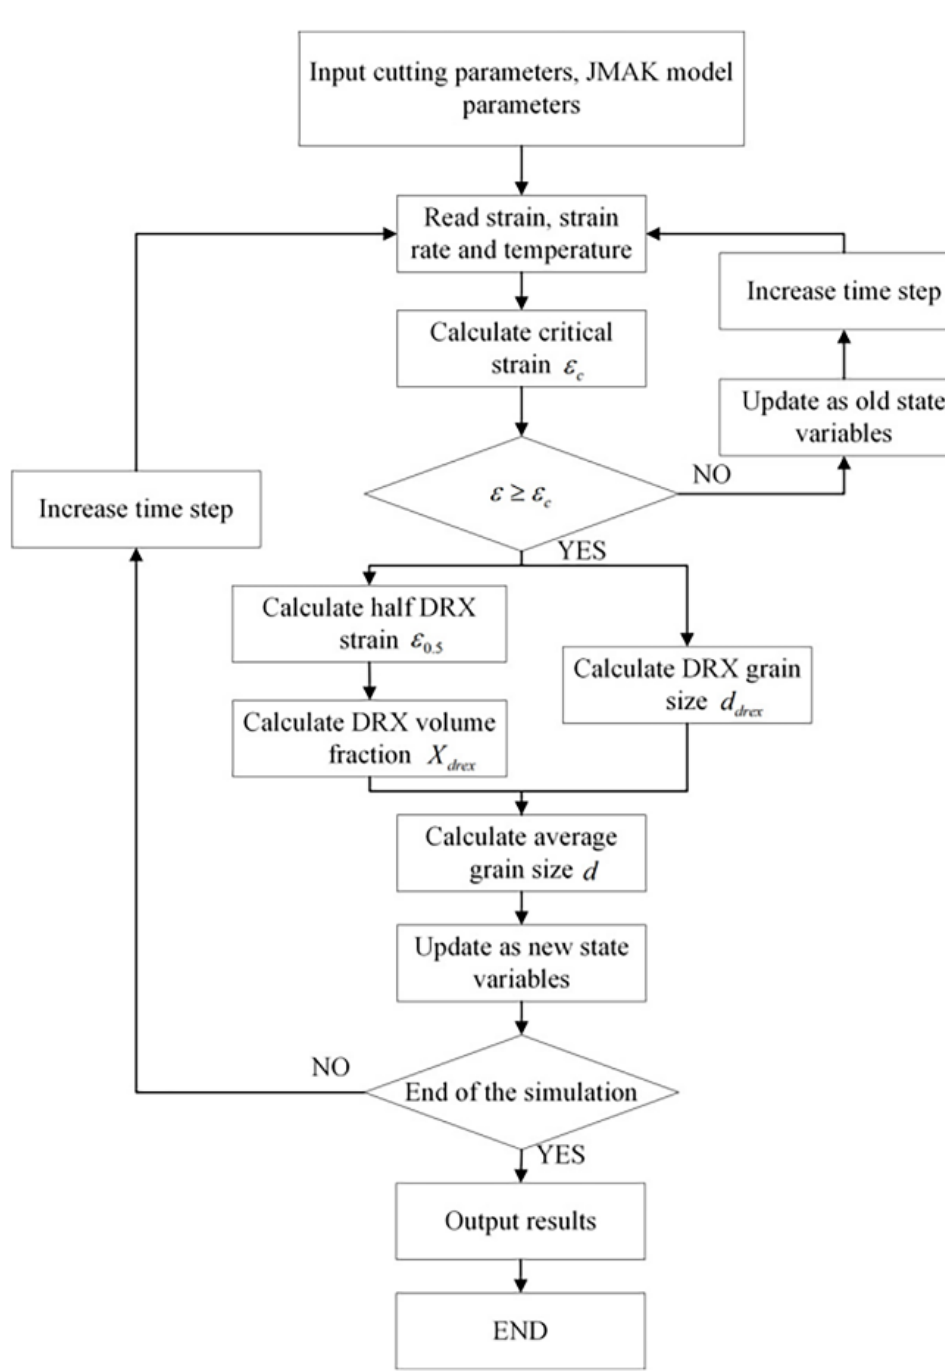
Figure 7. Flowchart of subroutine VUHARD using JMAK model.